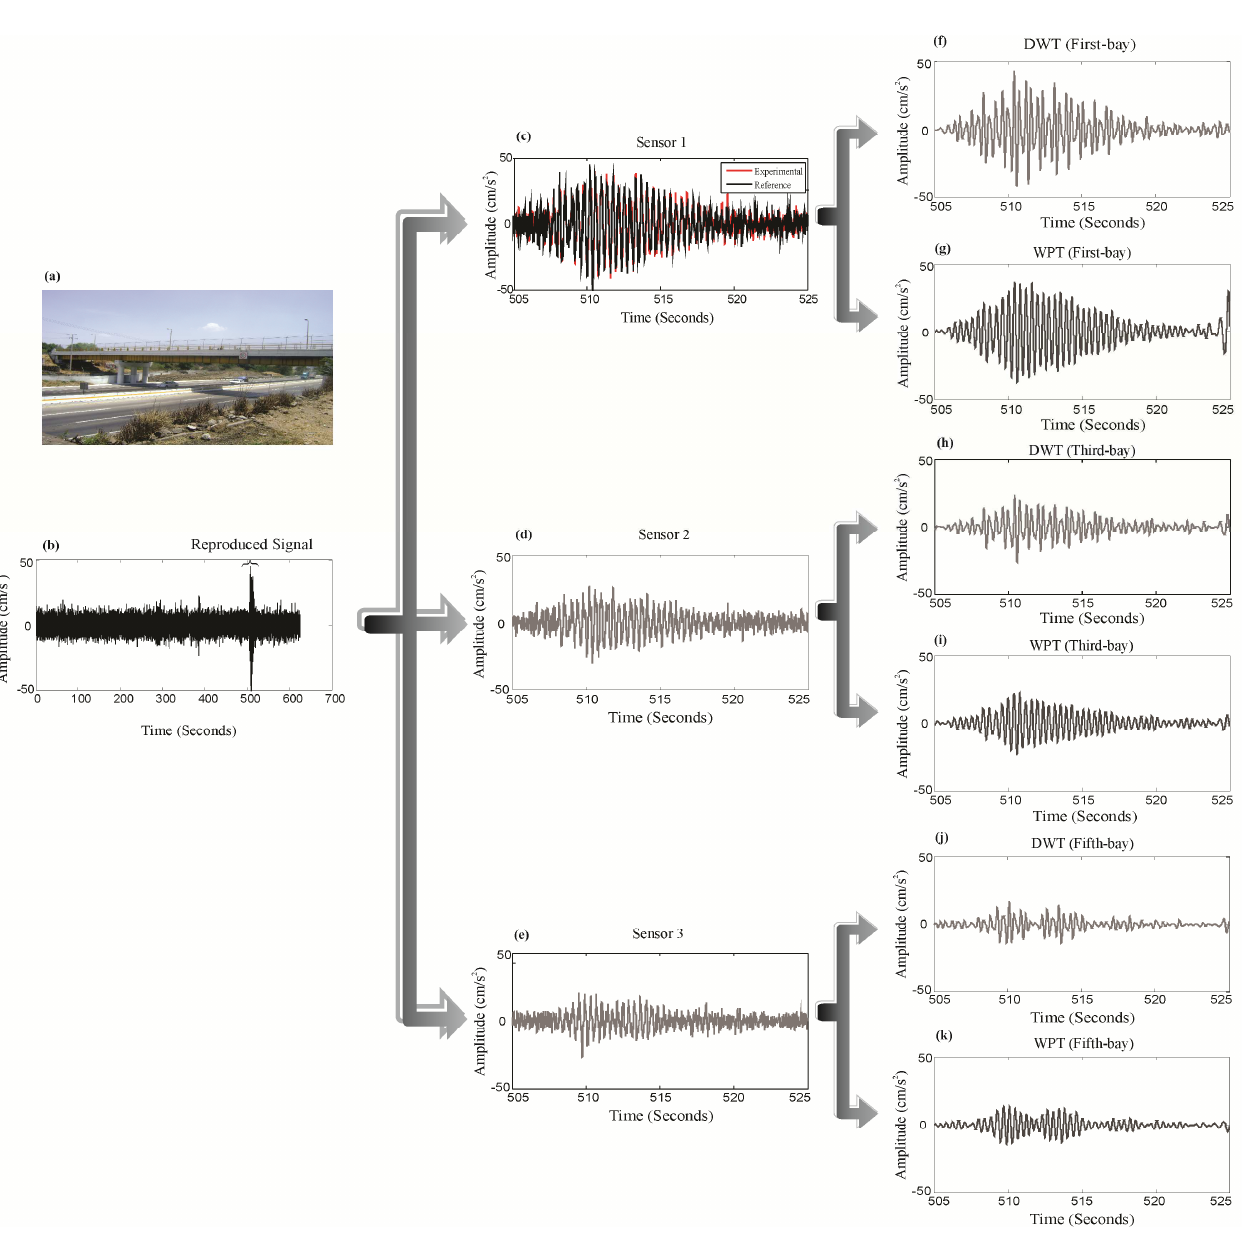
Figure 10. Ambient vibration. 2 Fig. 10. Ambient